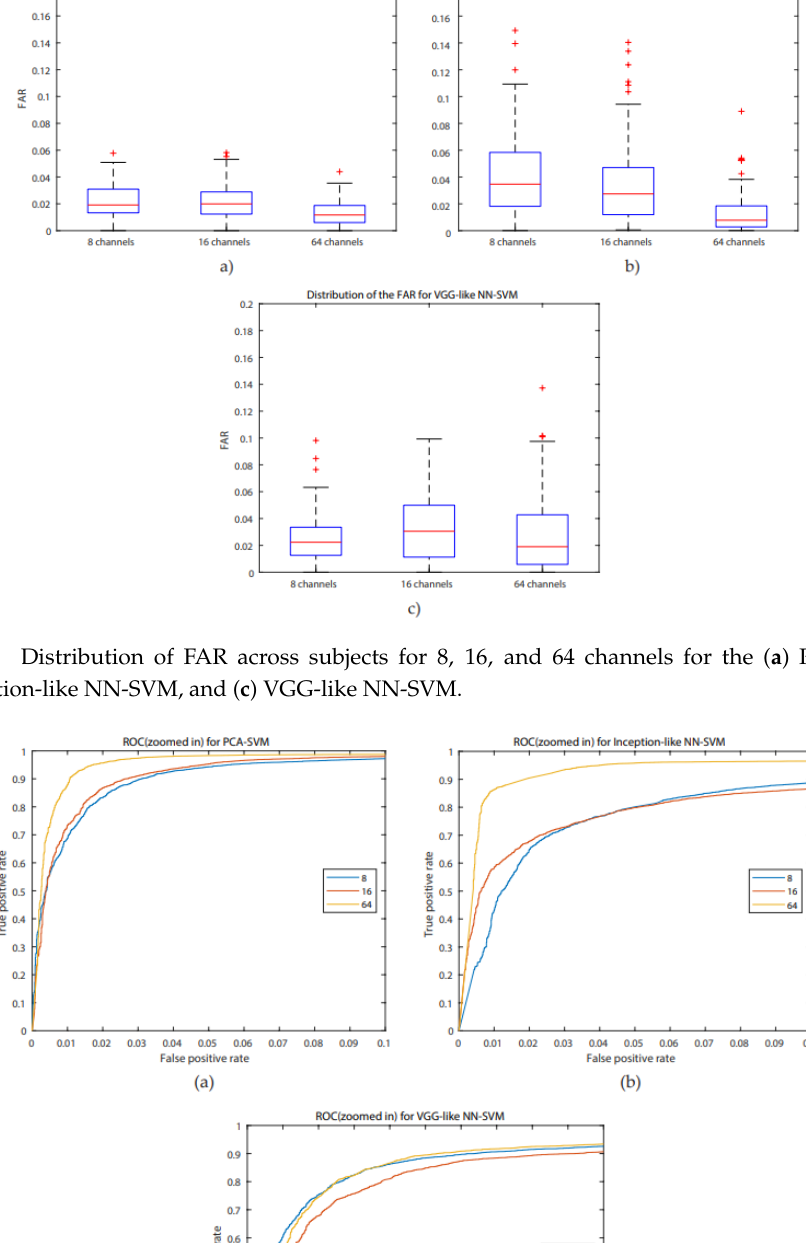
Figure 7. ROC curves for the PCA ‐ SVM (blue), inception ‐ like NN ‐ SVM (red), VGG ‐ like NN ‐ SVM (yellow) for a false positive rate (FAR) ranging from 0 to 0.1 to emphasize differences for 8 channels